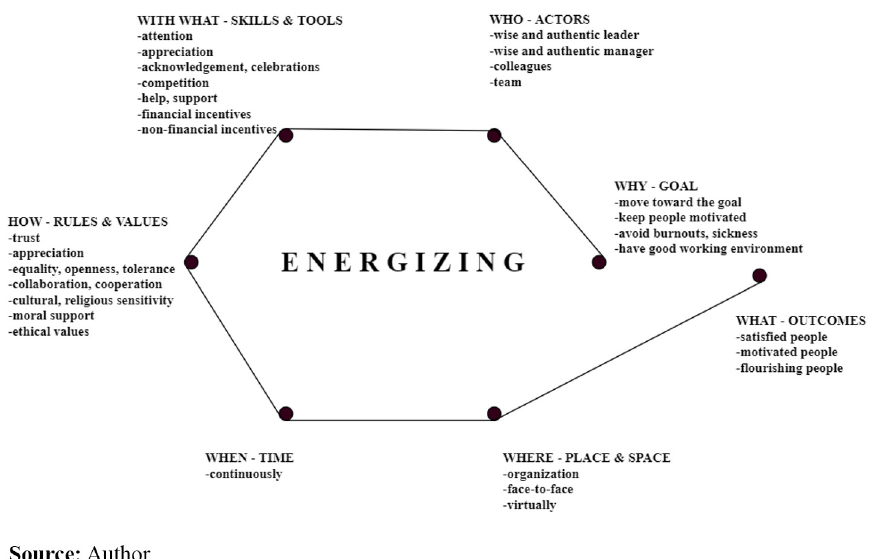
Figure 5. Energizing as PW- guided